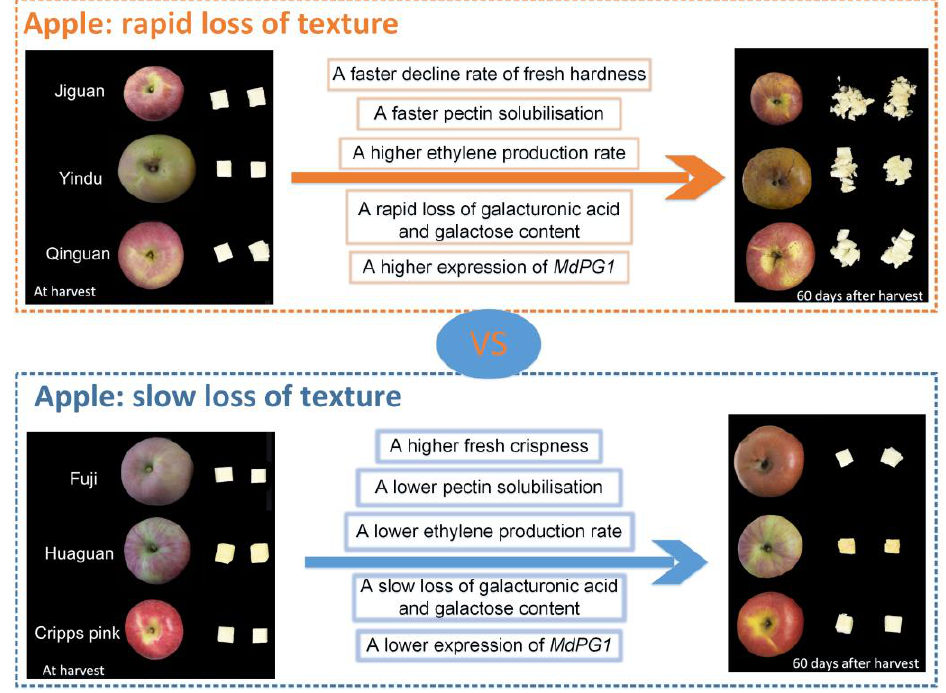
Figure 7. The schematic illustration of key points to a different loss rate of texture among apple cultivars.